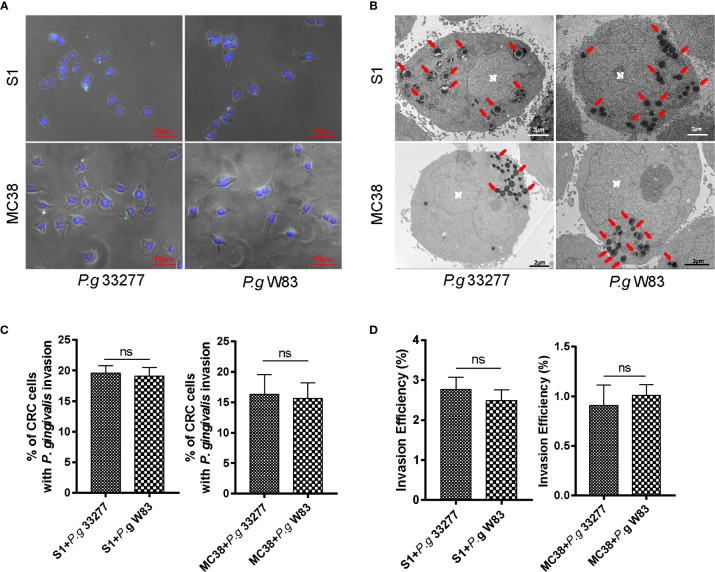
P. gingivalis exhibits high adhesion and invasive abilities toward colorectal cancer (CRC) cells. (A) Immunofluorescence micrographs show that P. gingivalis (green) can adhere to S1 and MC38 cells. (B) -Transmission electron microscopy (TEM) results indicate that P. gingivalis can intracellularly invade S1 and MC38 cells. (C) Percentage of CRC cells with P. gingivalis invasion were counted in 3 random fields (1000 ×, 30–50 CRC cells per fields)) by TEM and there is no significant difference between P. gingivalis 33277 and P. gingivalis W83. (D) Antibiotic protection assay shows that P. gingivalis can invade S1 and MC38 cells and survive inside the cell at 24 h after infection. The invasion efficiency of P. gingivalis 33277 and P. gingivalis W83 showed no significant difference. Invasion efficiency (%) = CFU of P. gingivalis inside CRC cells/CFU of P. gingivalis in initial inoculum. CFU, colony forming units. Red arrows, P. gingivalis infection in the cytoplasm. N, nucleus. ns, nonsignificant.